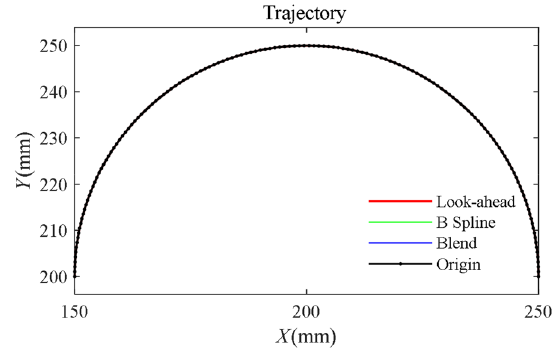
Figure 5 Comparison of semicircular trajectories for the three